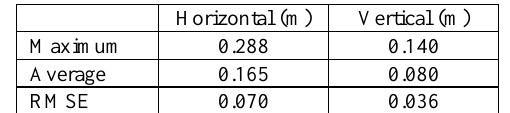
Table 5. Results of accuracy evaluation of the developed boat- loading system